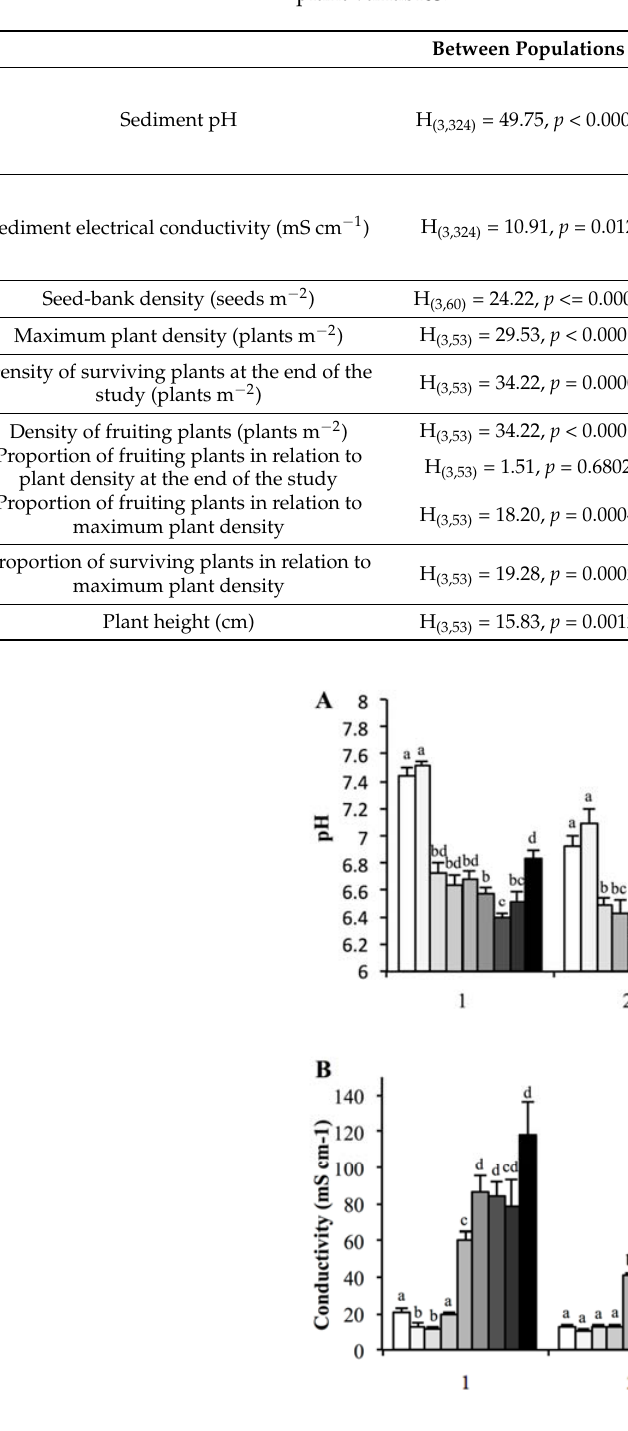
Figure 2. Sediment pH ( A ) and electrical conductivity (mS cm − 1 ) ( B ) for four Salicornia ramosissima populations from December 2019 to September 2020. Different letters indicate significant differences between dates for the same population (Mann–Whitney test, p < 0.05). Values are mean ± SE. The mean annual sediment EC varied between 33 ± 2 and 55 ± 5 mS cm − 1 , with no